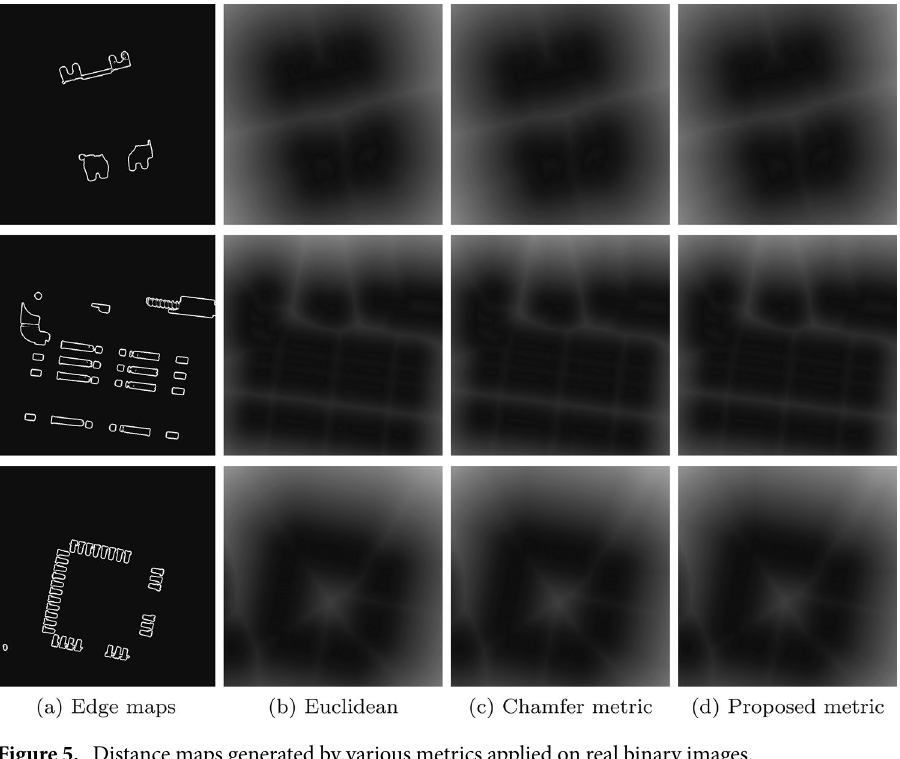
Figure 5. Distance maps generated by various metrics applied on real binary images.